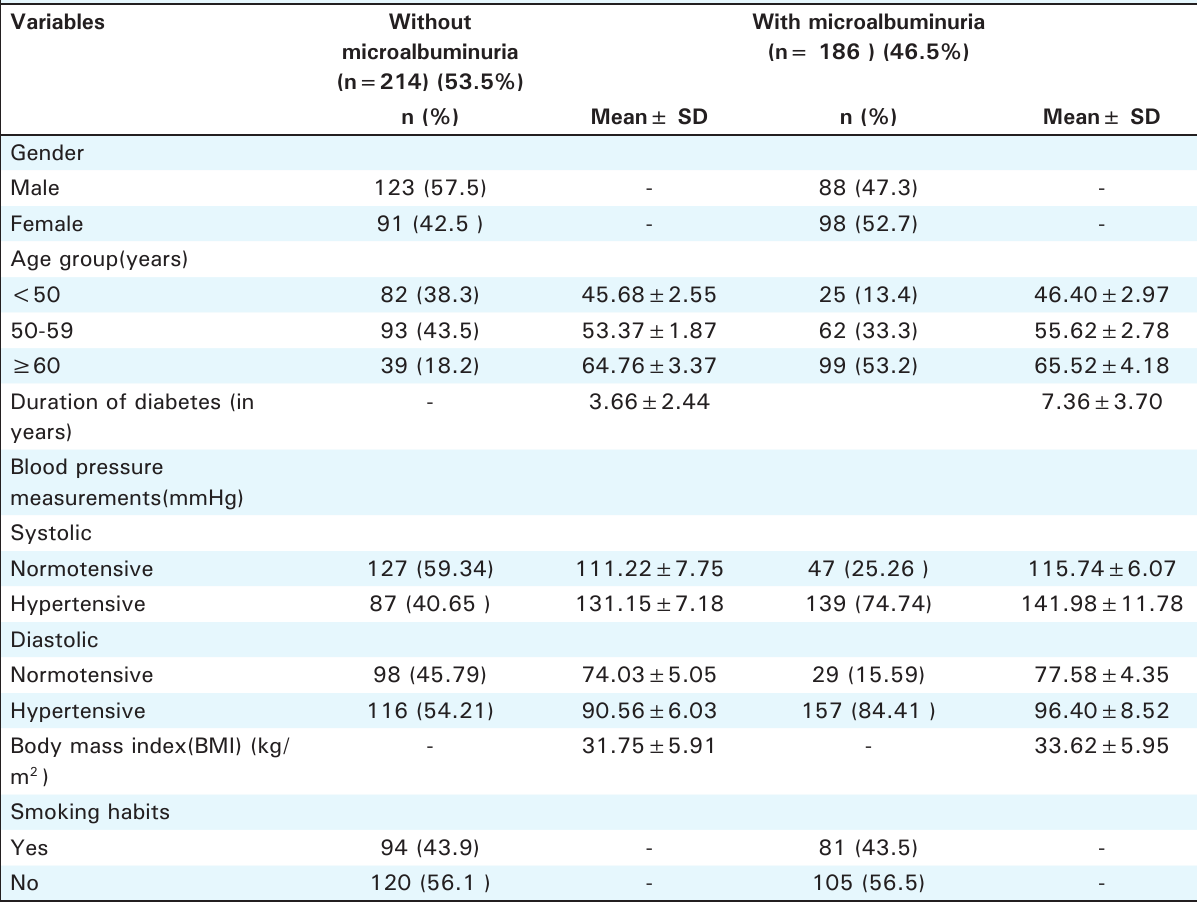
creatinine ratio were higher in microalbuminuria and found statistically significant difference